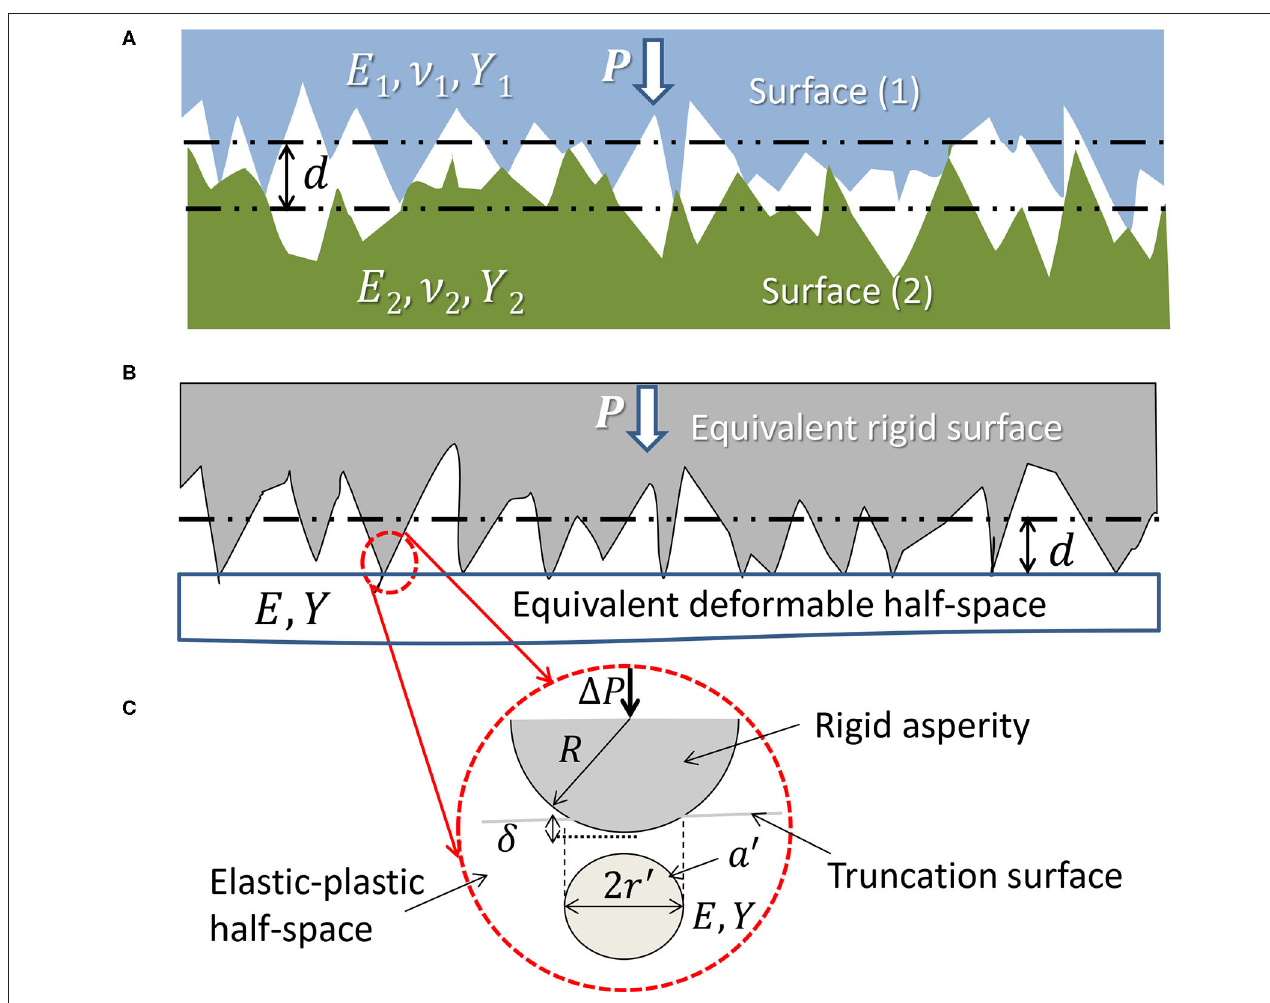
FIGURE 2 | (A) Contact of two rough surfaces confined at asperity microcontacts, (B) equivalent contact configuration of a deformable half-space with effective elastic-plastic material properties and an equivalent rigid and rough surface with fractal parameters those of the dominant surface power spectrum in the frequency range of interest, and (C) model of an asperity microcontact consisting of a rigid spherical asperity truncated by an elastic-plastic